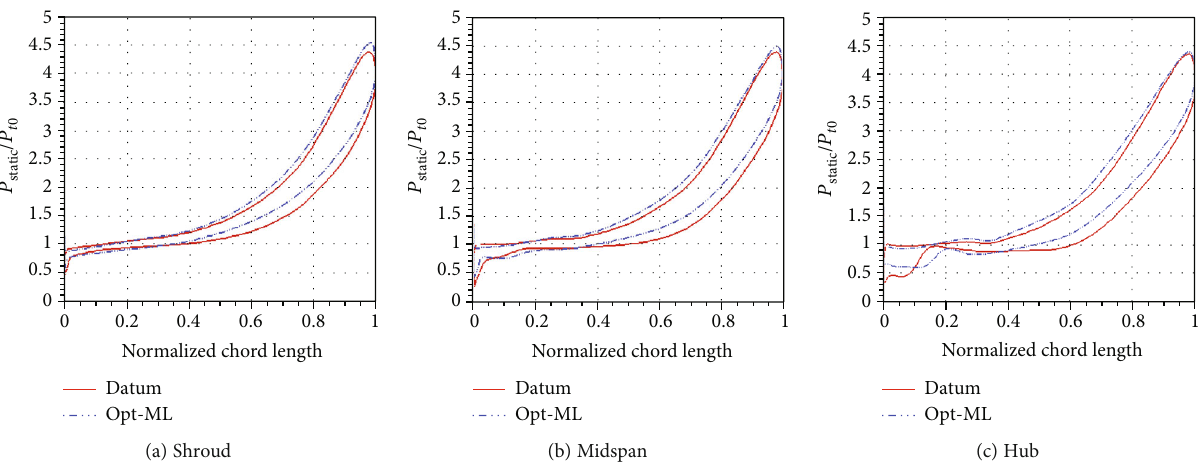
Figure 12: Comparison of the aerodynamic loading distribution at peak e ffi ciency points.